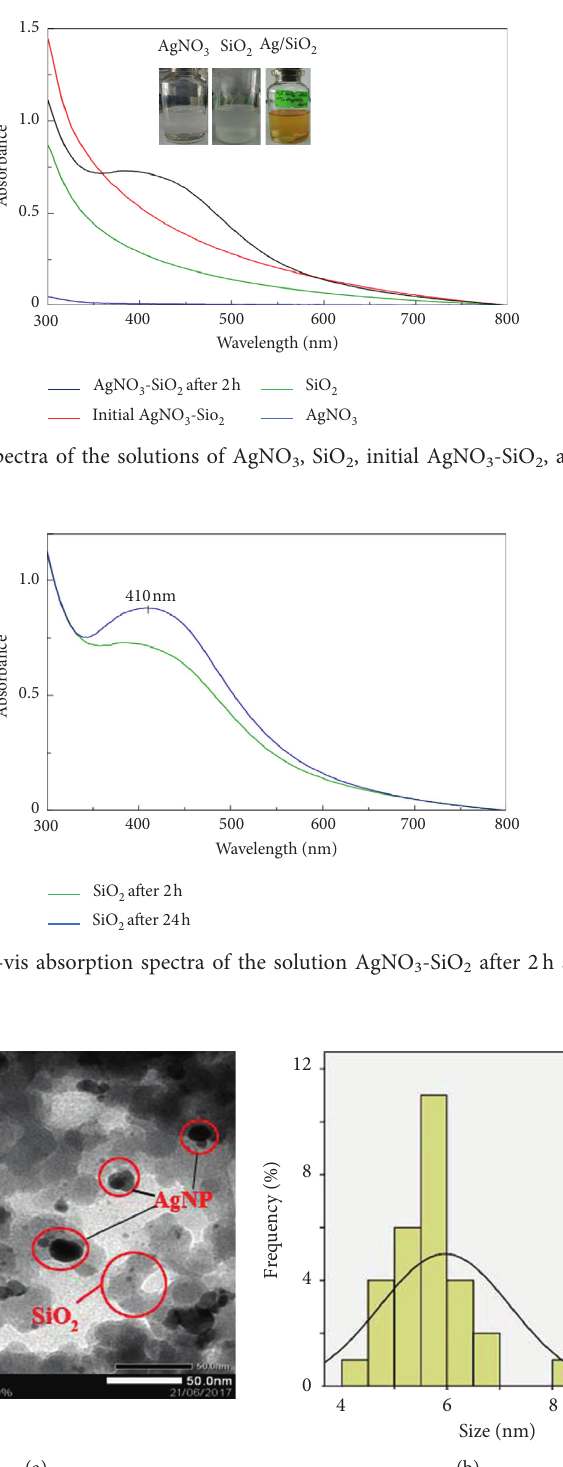
Figure 3: (a) a typical TEM image of the Ag/SiO 2 nanocomposite and (b) size distribution of AgNP from TEM